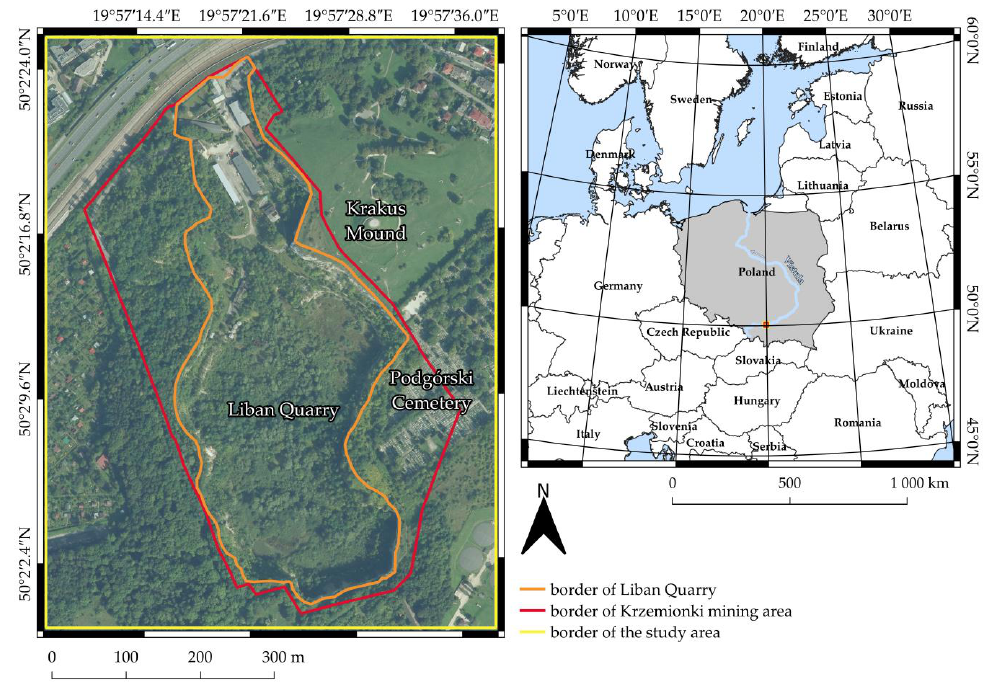
Figure 1. The location of the Krzemionki mining area and its surroundings with reference to nearby topographical objects and against the background of Europe and Poland (Europe, downloaded from https://tapiquen-sig.jimdofree.com/english-version/free-downloads/europe. Carlos Efraín Porto Tapiquén. Orogénesis Soluciones Geográficas. Porlamar, Venezuela 2015. Orthophotomap 2019 from https://mapy.geoportal.gov.pl/imap/Imgp_2.html?locale=pl&gui=new&sessionID=5031786).